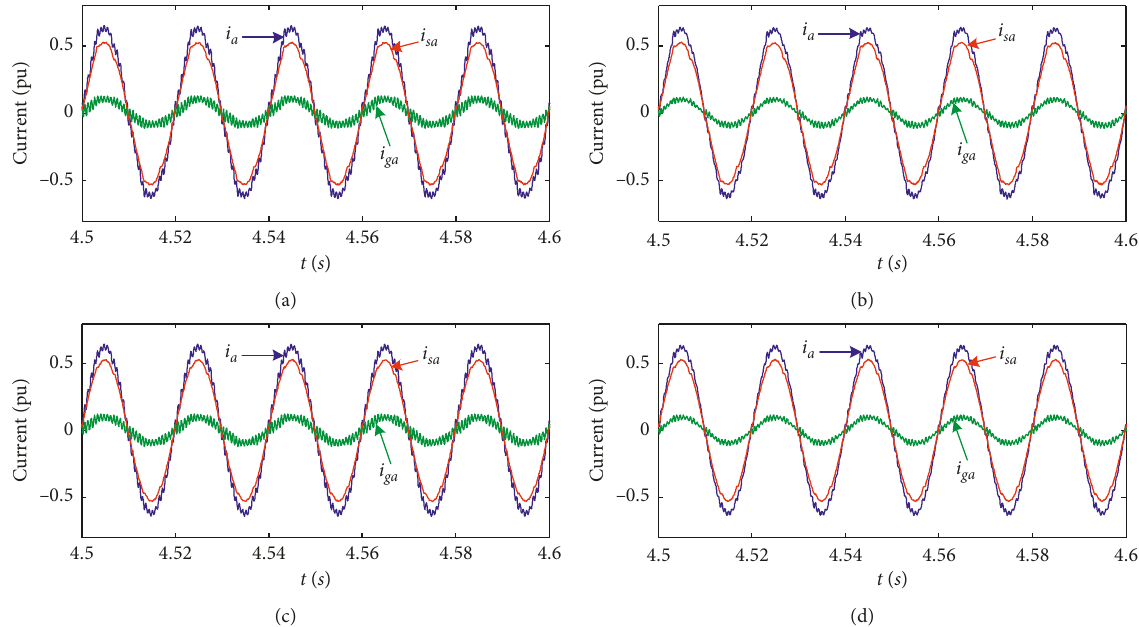
Figure 13: Currents i ga , i sa , and i a : (a) case 1; (b) case 2; (c) case 3; (d) case